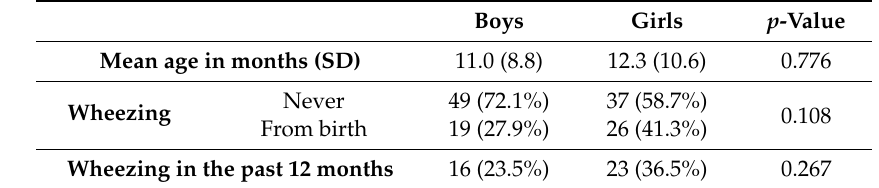
Table 1. Prevalence of wheezing by gender ( n = 131).